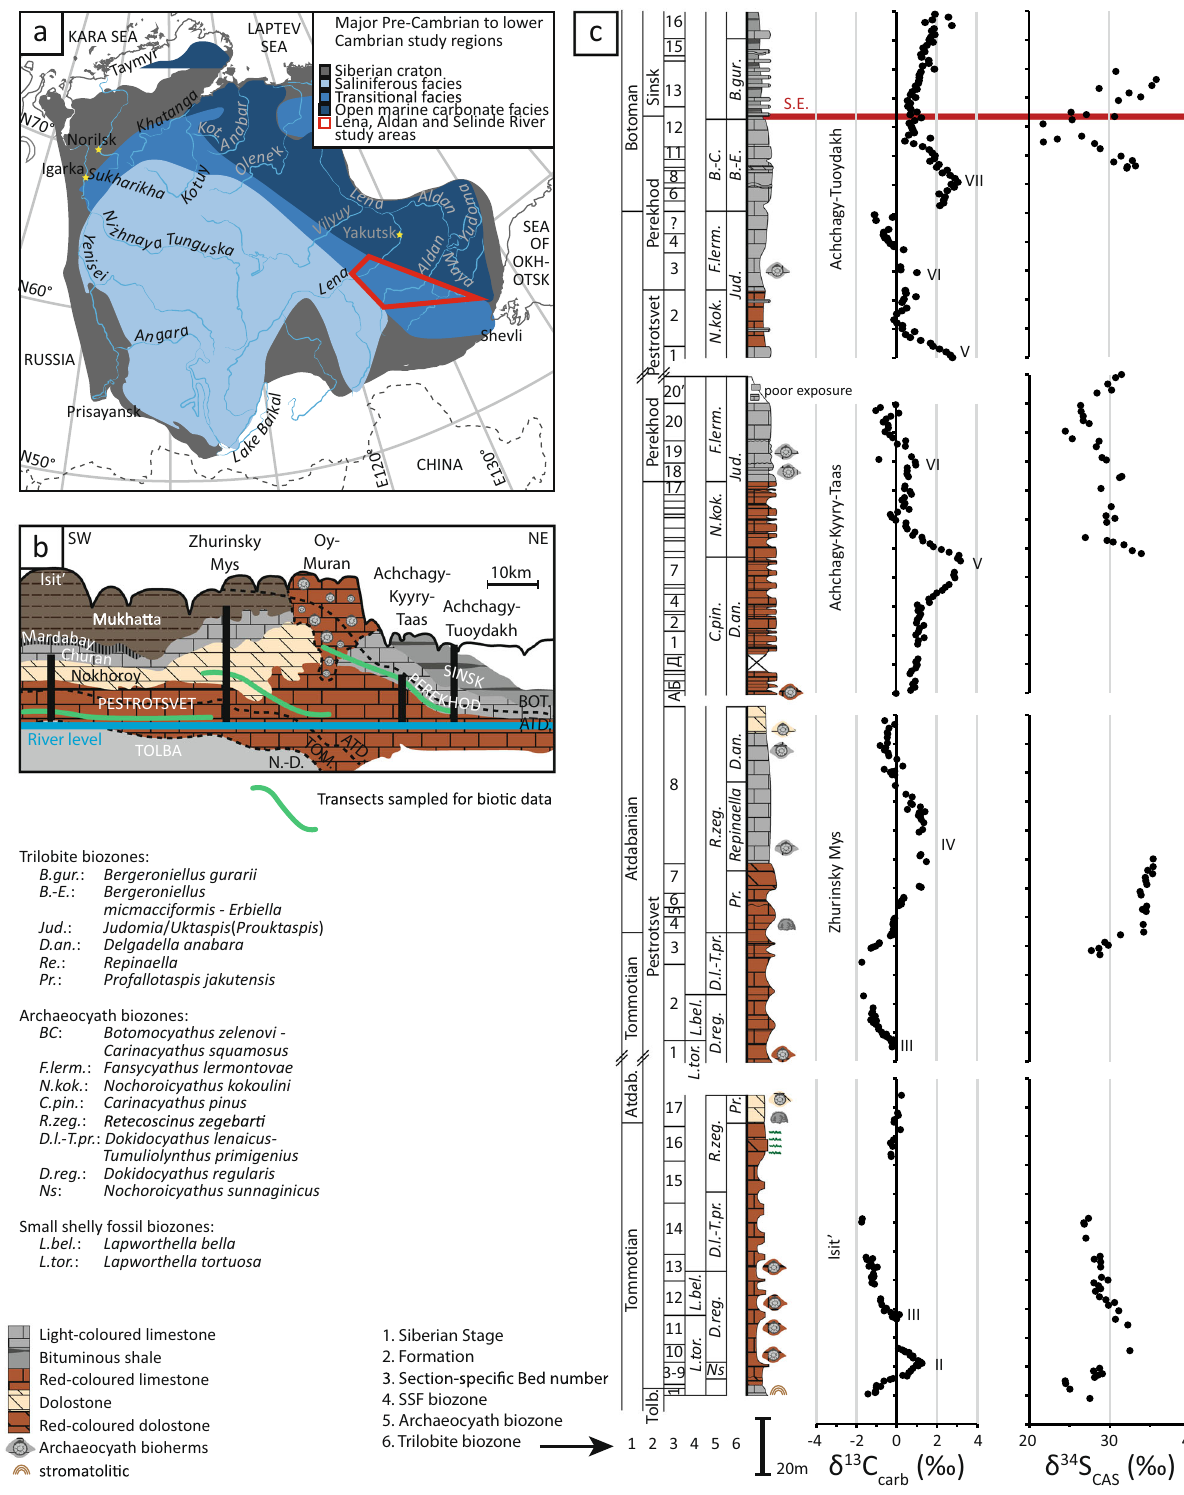
Fig. 1 | Palaeogeographic and stratigraphic position of the early Cambrian archaeocyath reefs of the Lena-Aldan area on the Siberian Platform. a Early Cambrian palaeofacies zonation map of the Siberian Platform. b Cross section to show relative positions of sampled transects along the Lena River 11,40,66 – 68